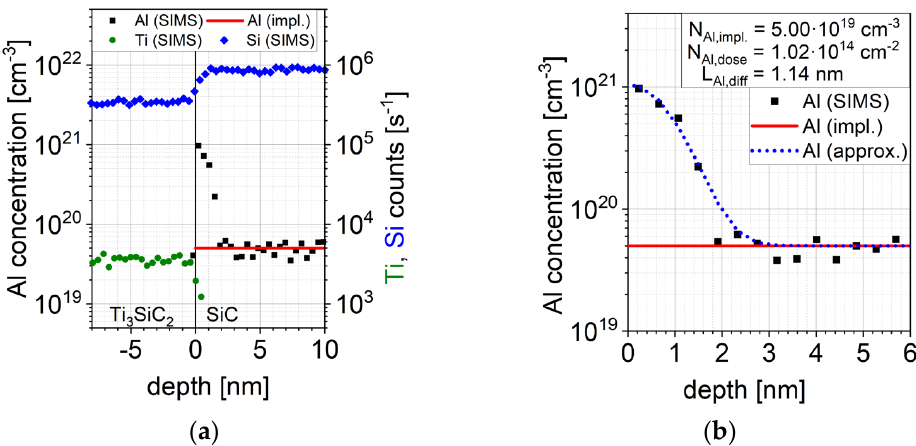
Figure 3. ( a ) Measured SIMS profiles of Al, Ti and Si on the Ti 3 SiC 2 -SiC interface ( b ) Approximation of the measured Al